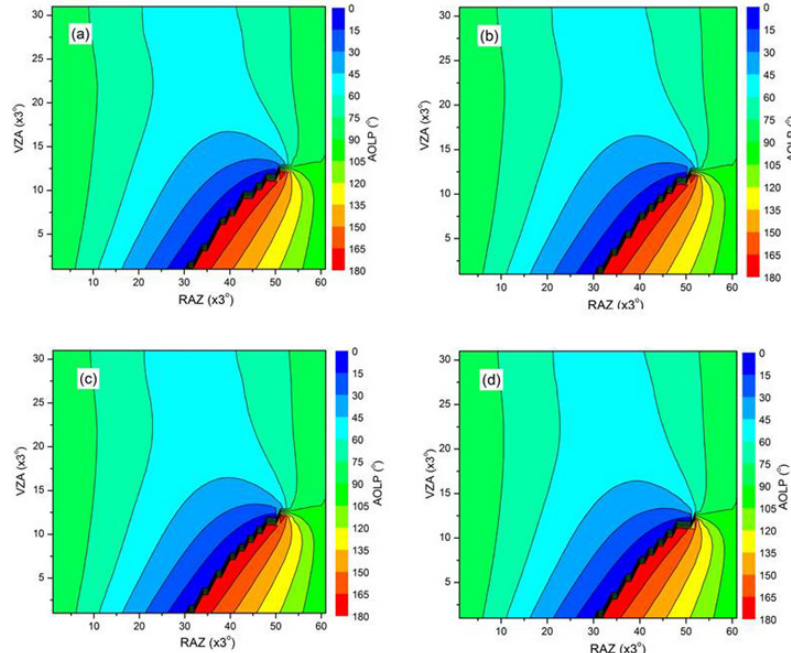
Fig. 9. Same as in Fig. 8, but for AOLP over RAZ of 0–180 ◦ at a wind speed of (a) 5.0ms − 1 , (b) 7.5ms − 1 , (c) 10.0ms − 1 , and (d) 15.0ms − 1 ,